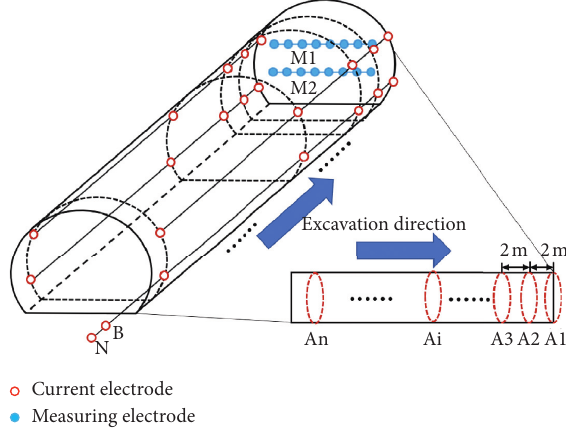
Figure 5: Schematic of the ER method observation system.